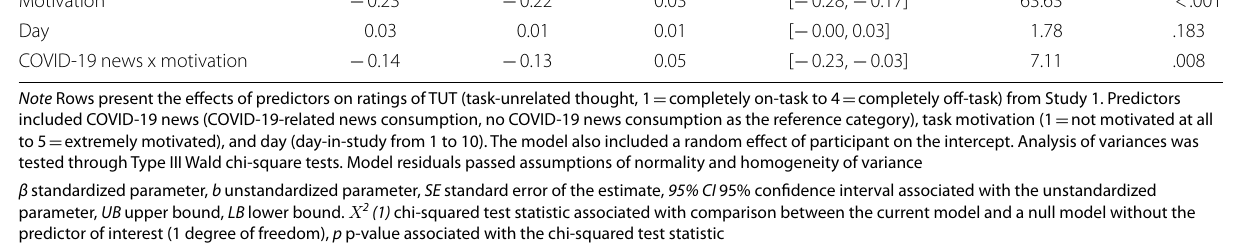
Table 1 Linear Regression Model Parameters for Predicting Task‑Unrelated Thought from COVID‑19 News Consumption (Study 1)